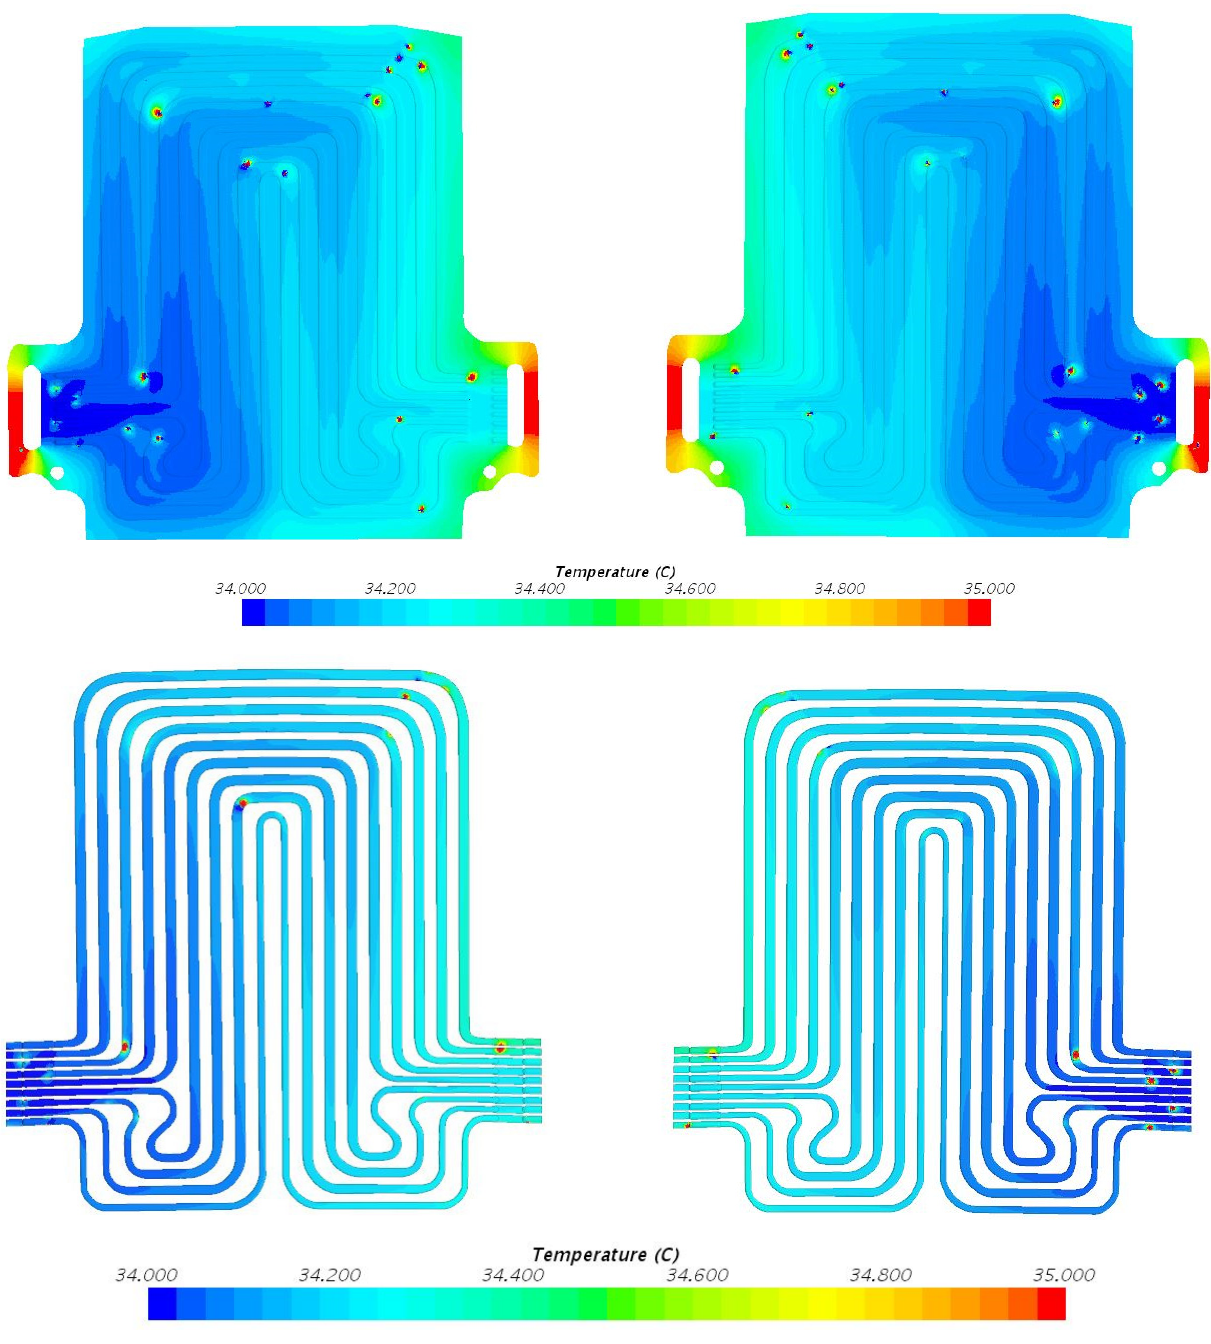
Figure 10. Temperature field at 20 A discharge current and 35 °C coolant inlet temperature with heat flux at position 1 = 47.6 W/m 2 , position 2 = 86.1 W/m 2 , and position 3 = 25.2 W/m 2 .